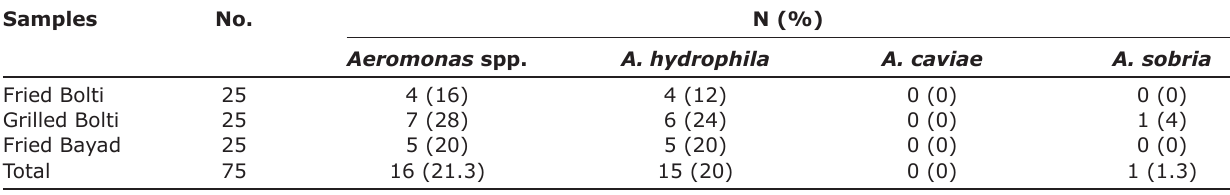
Table-3: Incidence of Aeromonas spp. in examined RTE fish samples. Samples No. N (%) Aeromonas